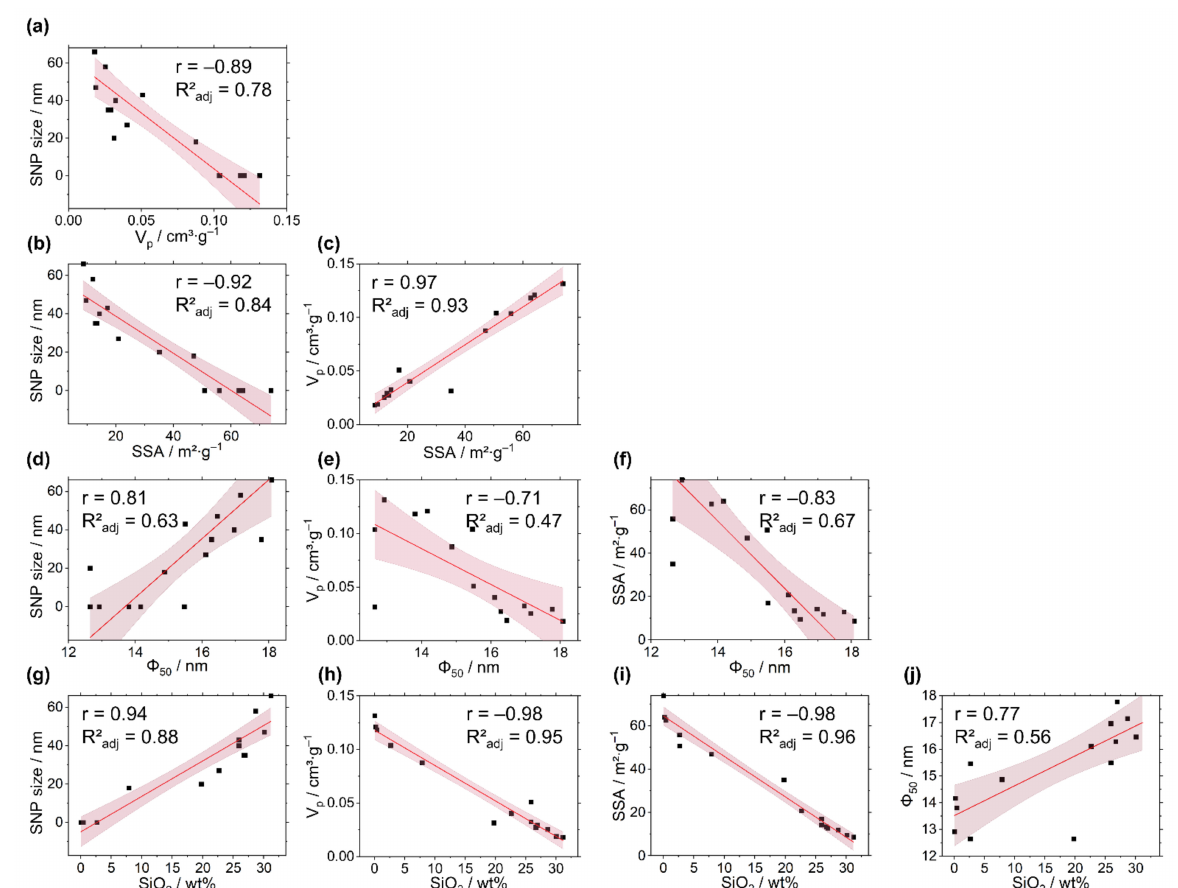
Figure 5. ( a – j ) Multiple scatterplots illustrating the correlations between response variables with Pear- son correlation coefficients r and R 2 adj fit parameters. Red lines indicate linear fits. 95% confidence intervals are given by shaded